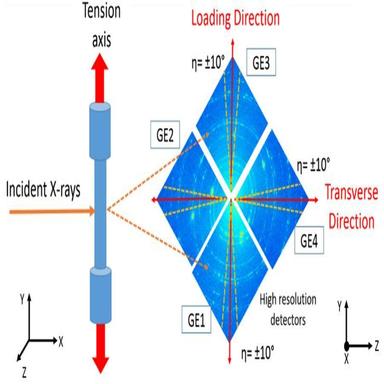
Schematics of the experimental set-up and detectors at beamline 1-ID, with the X-ray beam incoming along the X axis and the tensile load direction along the Y axis, h being the azimuth angle (note the diffraction pattern shown is for illustration only and not actual data collected for this study).